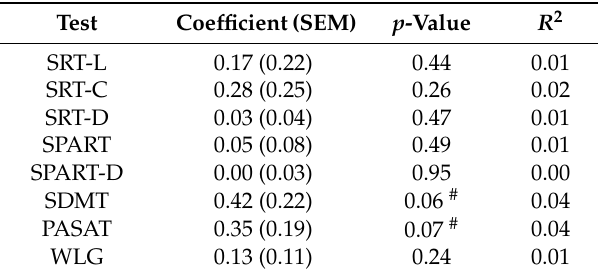
Table 4. Simple linear regression coefficients between aerobic capacity and cognitive